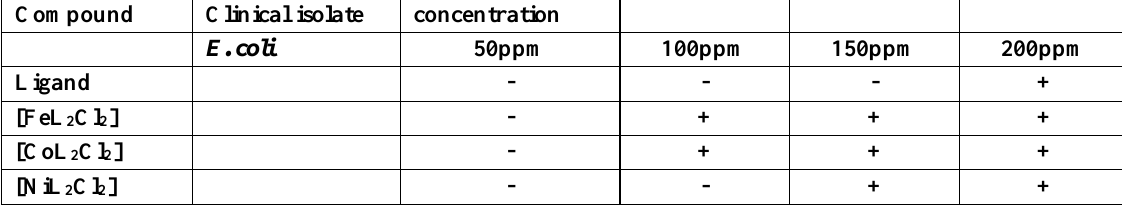
Table 7. Minimum inhibitory concentration (MIC) of Schiff base ligand and its metal complexes. Compound